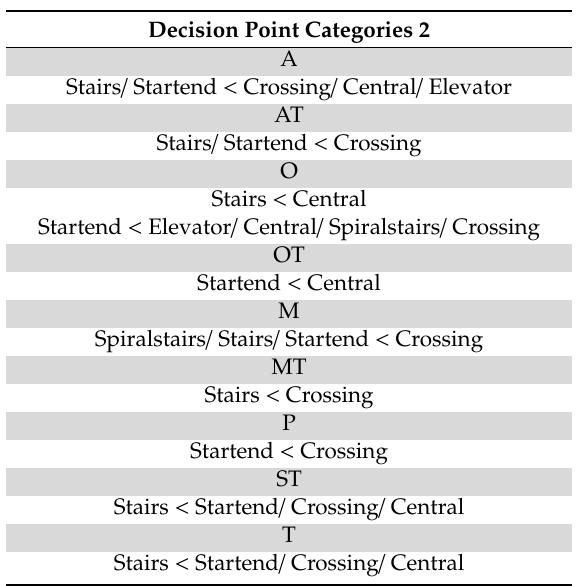
Table 6. Rankings of decision point categories 2 (stairs, elevator, spiralstairs, central, crossing) from low to high ratings for every instruction type, resulting from pairwise one-tailed Mann-Whitney U